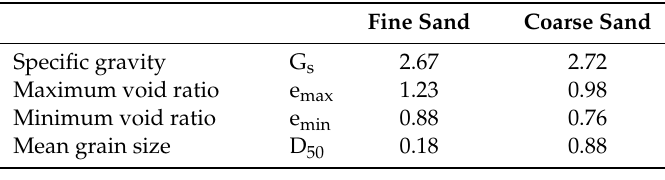
Table 1. The physical properties of the local sands used.